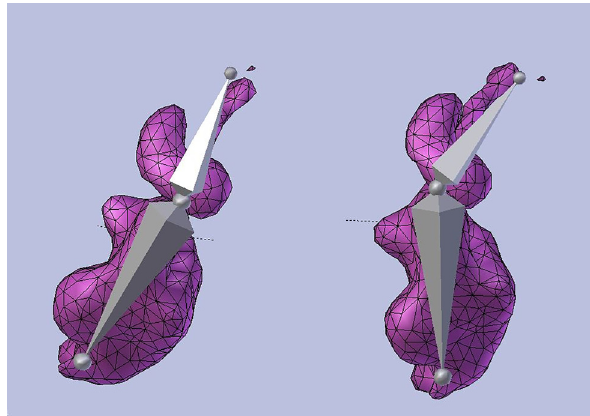
Figure1: Amolecularsurfacemodelofmyosin(pdb1MYS) deformed by skeletal animation. The hypothetical bending motion of the myosin, known as the power stroke, can be examined by defining the translation and rotation